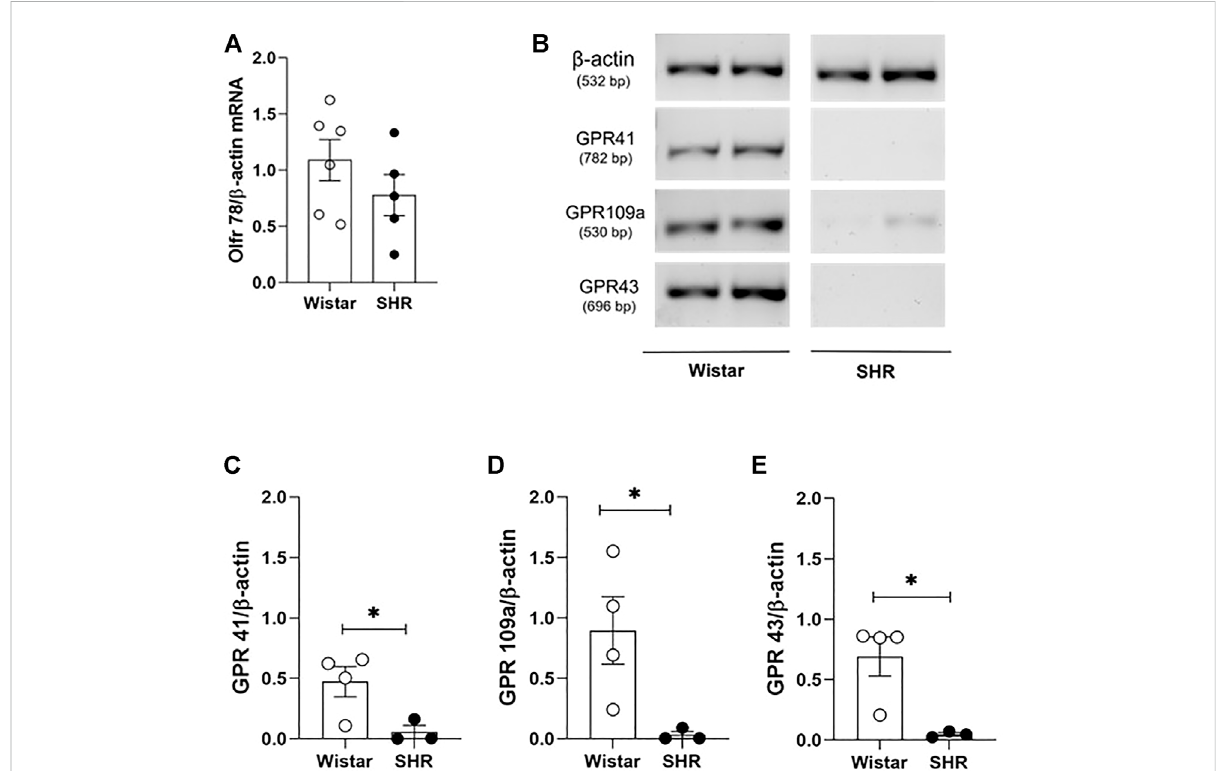
FIGURE 5 Reduced mRNA levels of short chain fatty acids (SCFAs)-sensing receptors on mesenteric resistance arteries of adult SHR. Relative receptor expressionwasevaluatedbytwodifferentPCRapproaches. (A) mRNAlevelsofOlfr78receptor,analyzedbyqRT-PCR; (B) representativeresultsfrom RT-PCR analysis after evaluation on 1% agarose gel electrophoresis of (C) GPR41, (D) GPR109a and (E) GPR43 receptors present on mesenteric resistance arteries of adult Wistar and SHR. In the qRT-PCR result, mRNA relative quanti fi cation was calculated by the 2 - ΔΔ Ct method; whilst for RT-PCR analysis, gene expression was obtained with normalization of the values from the ampli fi cated receptor ’ s bands, by values from the internal control. The number of animals used in each group is expressed in the graphic dots. Values are presented as the mean ± SEM. The statistical analysis was assessed by Student ’ s t -test: * p < 0.05 vs